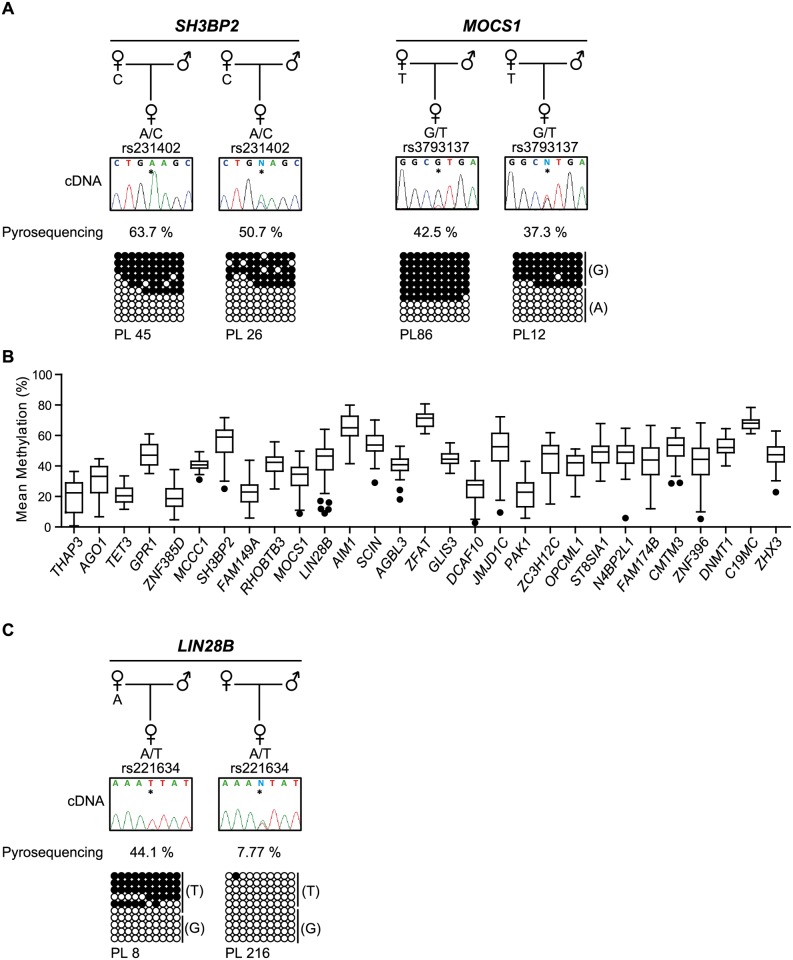
Allele-specific expression and methylation analysis of genes with variable maternal placenta-specific gDMRs.(A) Allelic RT-PCR analysis for SH3BP2 and MOCS1 in placenta samples with bisulphite PCR and subcloning of the associated gDMR in the same biopsy. Each circle represents a single CpG dinucleotide on a DNA strand, a methylated cytosine (•) or an unmethylated cytosine (o). For clarity only the first 10 CpG dinucleotides are shown. (B) Pyrosequencing quantification of 29 placenta-specific DMRs reveals hypomethylation indicative of a stochastic trait. The average methylation of 55 controls placenta samples from uncomplicated pregnancies reveals profiles consistent with one methylated and unmethylated allele. The controls represented as Tukey box-and-whisker plots with whiskers spanning from 25th to 75th percentiles +/- 1.5IQR to highlight outliers. Individual hypomethylated samples are highlighted. (C) Allelic specific RT-PCR and strand-specific bisulphite PCR and subcloning of placenta samples lacking maternal methylation at LIN28B identified in (B) compared to a normal imprinted control sample.